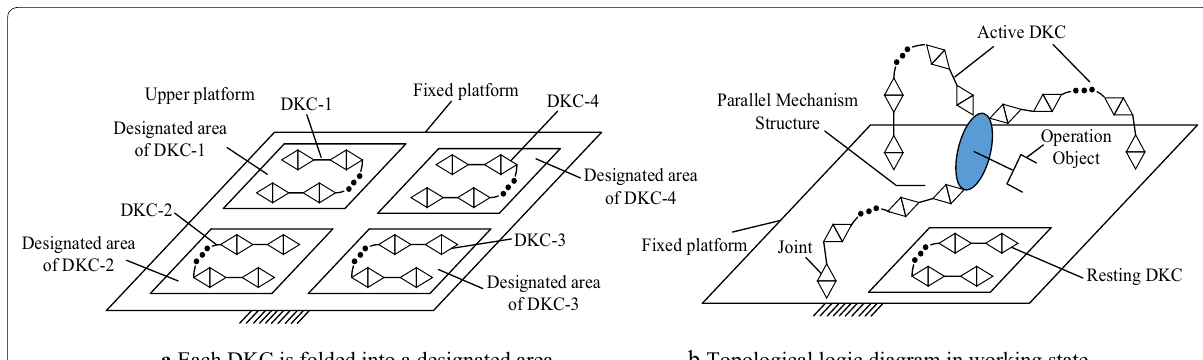
Figure 1 Topological logic diagram and working mode of the Type‑I mechanism